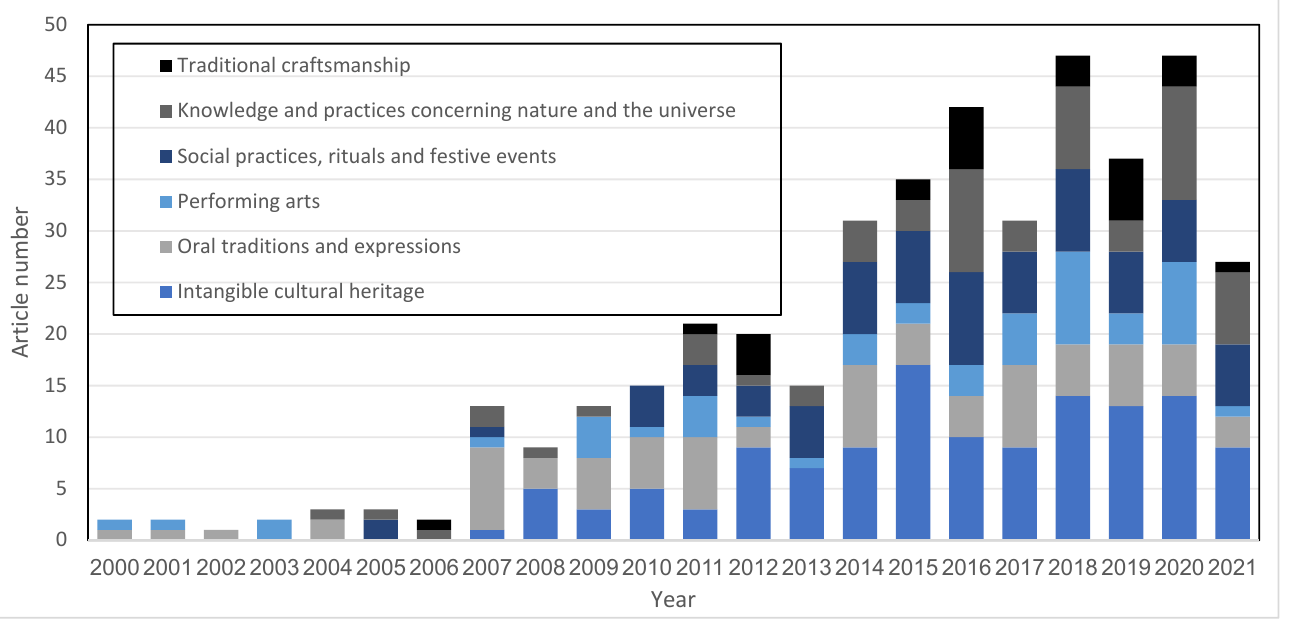
Figure 3. Years and category distribution of papers from WOS by publication. Source: edited by authors.